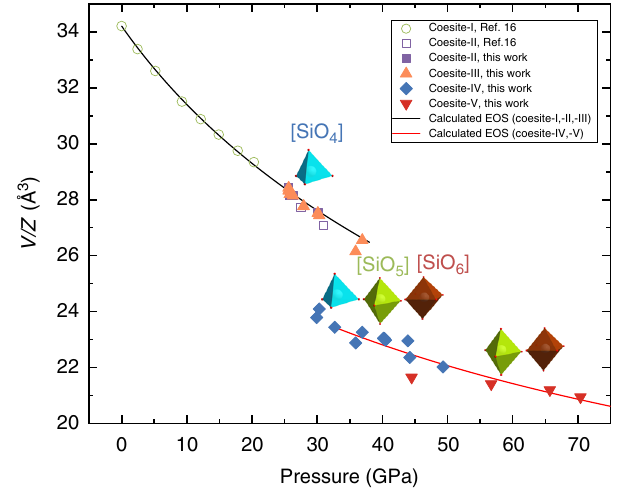
Fig. 1 The P – V data of squeezed coesite. Unit cell volumes are normalized to the number of formula units Z . Open symbols represent literature data 15,16 (in the present work, we used samples of the same coesite which was studied in refs. 15,16 ). The black solid line represents a fi t of all the VP - data for coesite-I, II, and III with the Birch – Murnaghan equation of state (EOS) ( V 0 / Z = 34.20(1) Å 3 , K 0 = 103(2) GPa, and K ´ = 3.02(15)). Combined pressure – volume data for coesite-IV and coesite-V were fi tted with the second-order Birch – Murnaghan equation of state ( V 32.7 / Z = 23.44 (3) Å 3 , K 32.7 = 254(9) GPa) and are shown on the graph by a solid red line. Colored polyhedra indicate the building blocks characteristic for the structures of silica polymorphs in the corresponding pressure regions. Uncertainties in the unit cell volumes are less than the symbol sizes and are therefore not shown. As seen, coesite-III and coesite-IV show signi fi cant scatter in values of the unit cell volumes that might be attributed to different deviatoric stresses in samples from different